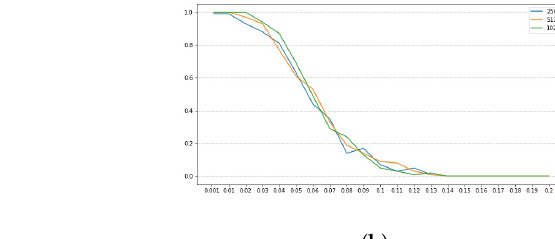
0.001,0.01,0.02, . . . ,0.2 . ∈ { }